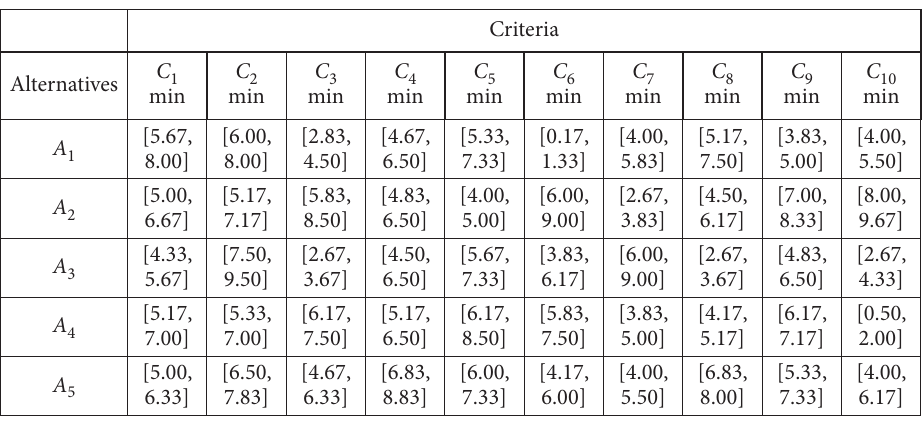
Table 8. Average grey decision making matrix